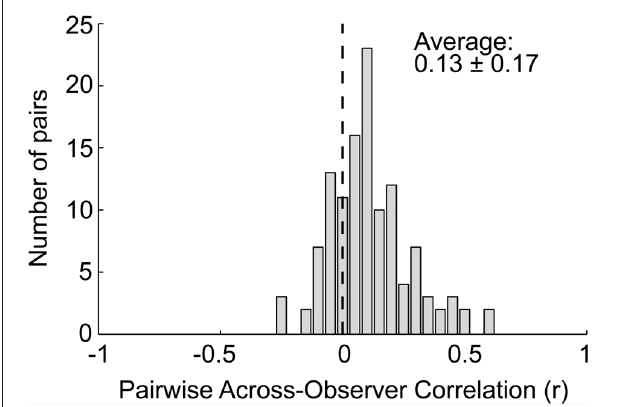
FIGURE 2 | The distribution of pairwise correlations across observers’ recommendations, illustrating highly individual responses. Each observer’s recommendations were correlated with every other observer’s recommendations, taken in pairs. This histogram shows the distribution of all the correlation coefficients.